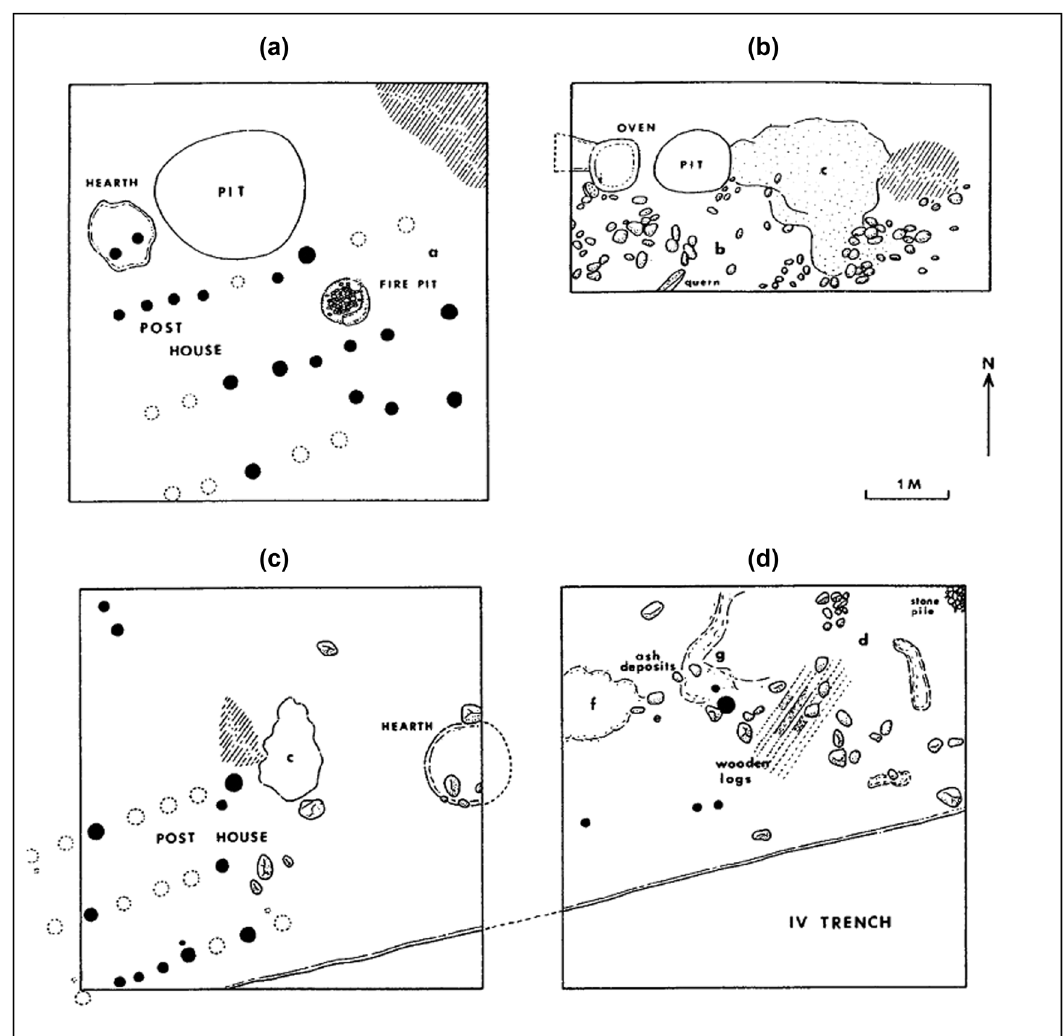
Figure 8: Architectural remains of phases IIa ( squares a and b ) and IIb ( squares c and d ) at Achilleion ( Winn & Shimabuku, 1989, Figure 4.7 and 4.11 )